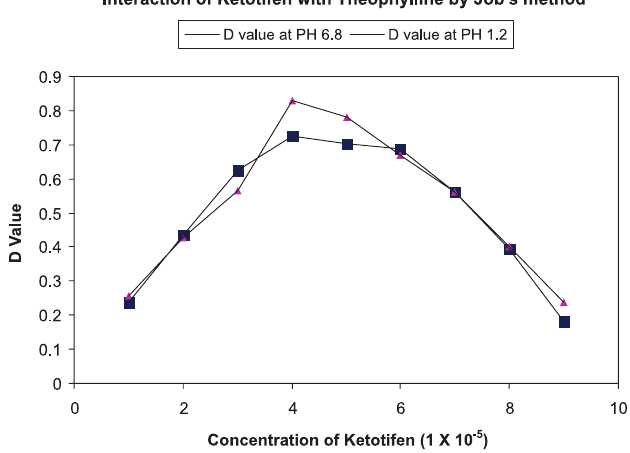
FIGURE 1 - Job’s plot for the complexation of ketotifen with theophylline at 300 TABLE I - Absorbance of ketotifen at different pH (using Job’s method)